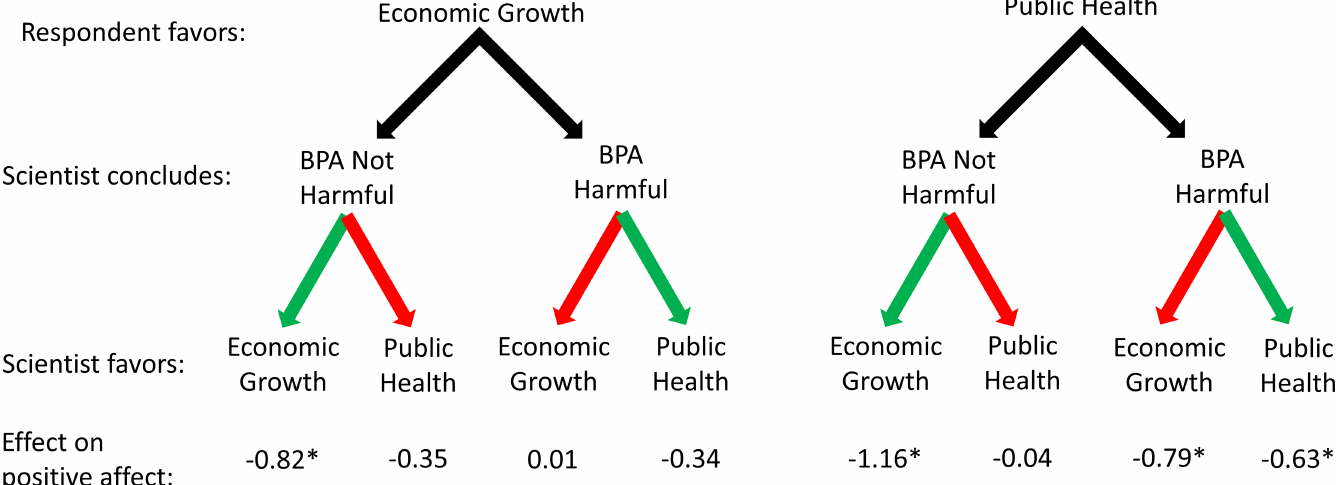
Fig 1. Effects of scientists’ conclusions and expressedvalues on respondents’ positive affect toward them. Effects are relativeto a scientist not expressinga preferencefor particular values and are net of control variables; see Table 1. Green arrows are used when the scientist’s conclusioncoincides with the scientist’s values; red arrows are used when the scientist’s conclusionconflicts with the scientist’s